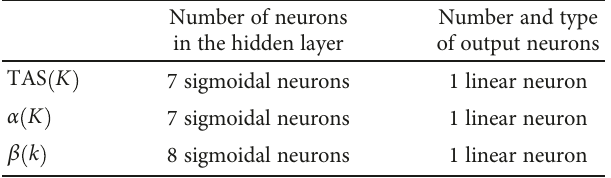
Table 3: Neural network architectures.